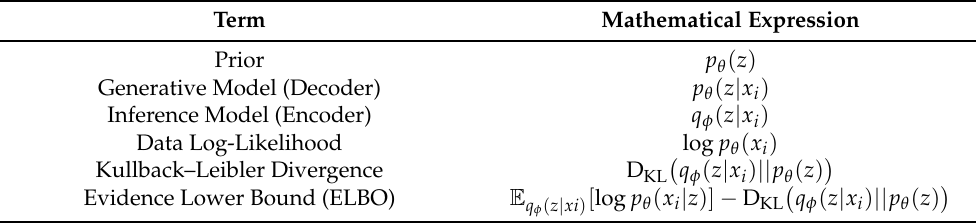
Table 2. Overview of the main terms and corresponding mathematical expression.